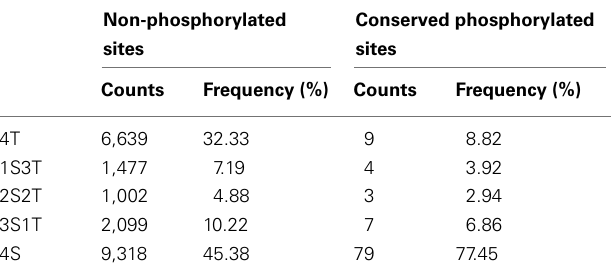
Table 3 | Distribution of S andT in non-phosphorylated and conserved phosphorylated classes.